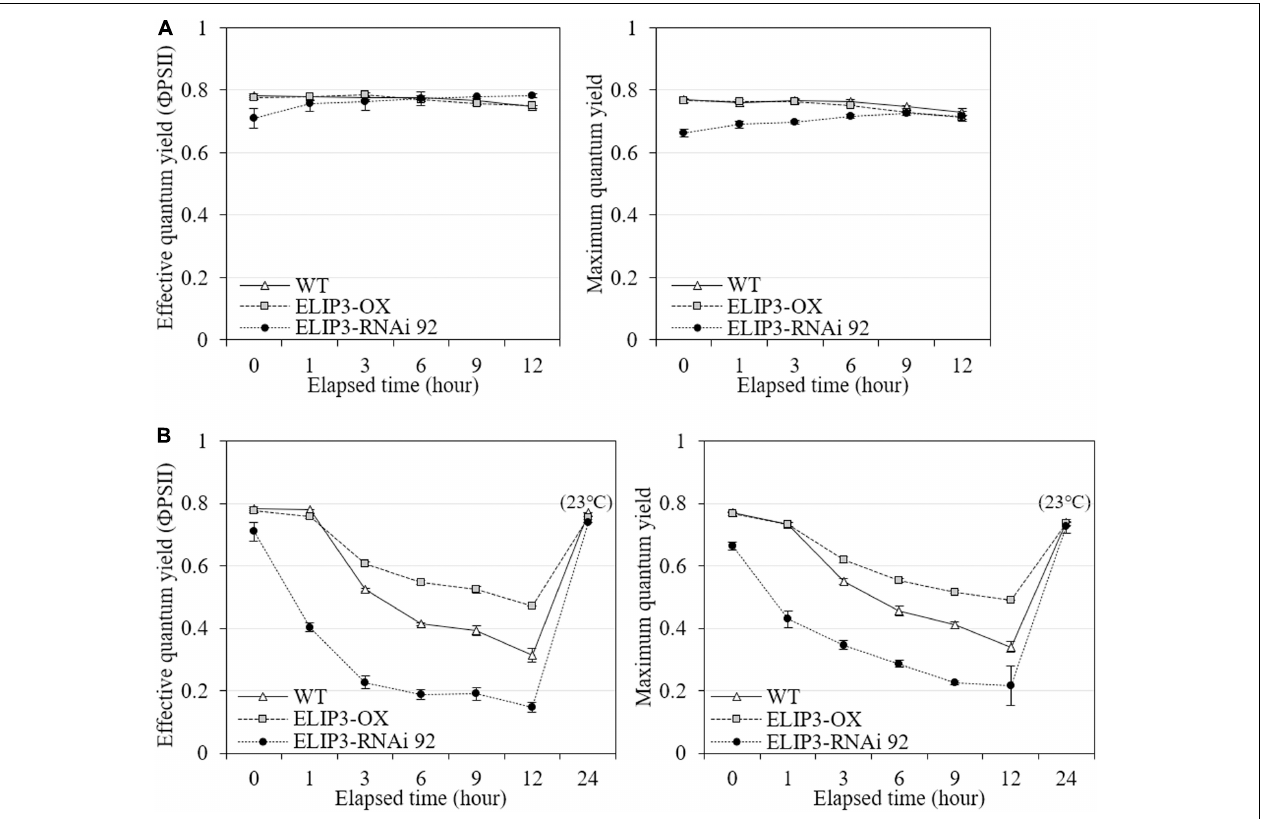
FIGURE 8 | Effective quantum yield and maximum quantum yield measurements. Comparison of effective and maximum quantum yields from fluorescence measurement between WT, overexpression strain (OX) and knockdown strain (RNAi 92) at (A) 23 ◦ C and (B) 4 ◦ C. The strains measured at 4 ◦ C were incubated at 23 ◦ C under dark condition for 12 h, then recovery measured. Values represent the mean ± SD ( n =